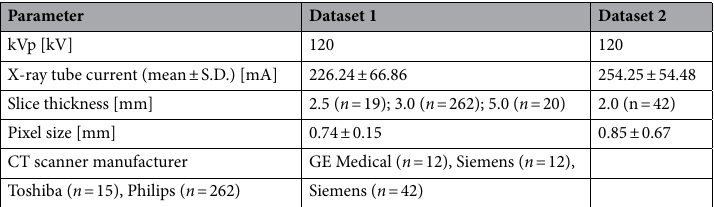
Table 2. Parameters for CT image acquisition.